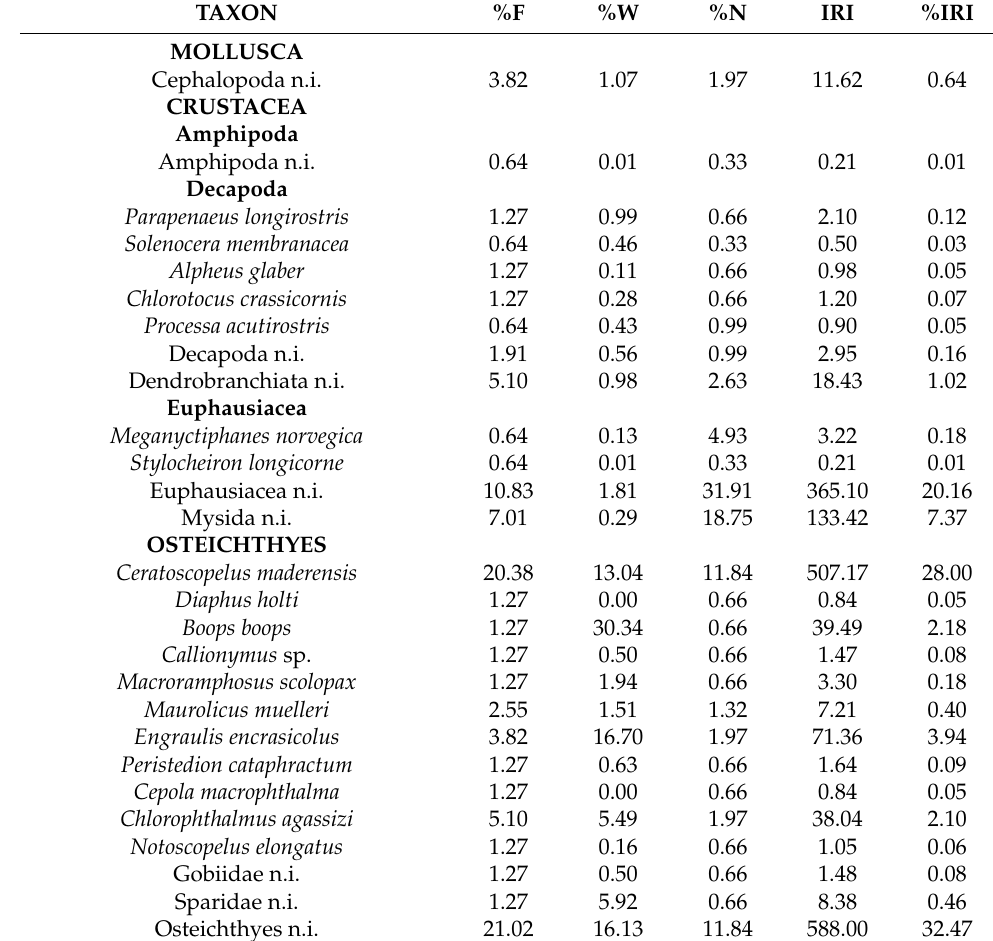
Table 2. Diet composition of the whole hake’s series from southern and central Tyrrhenian Sea sampled in 2018. In the columns are reported the diet index values (%F, %W, %N, IRI and %IRI) for each prey